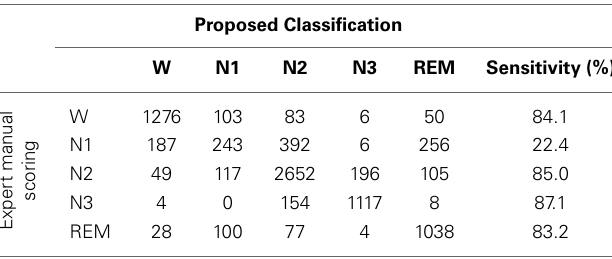
Table 6 | Confusion matrix: proposed sleep classification approach vs. expert manual